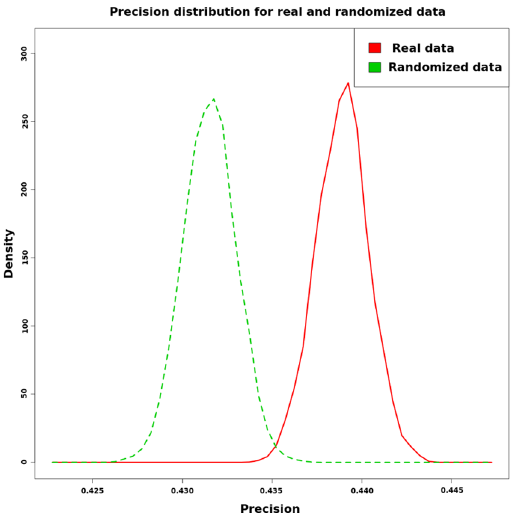
Figure 3. Precision distribution of our method with real observed and randomized data.